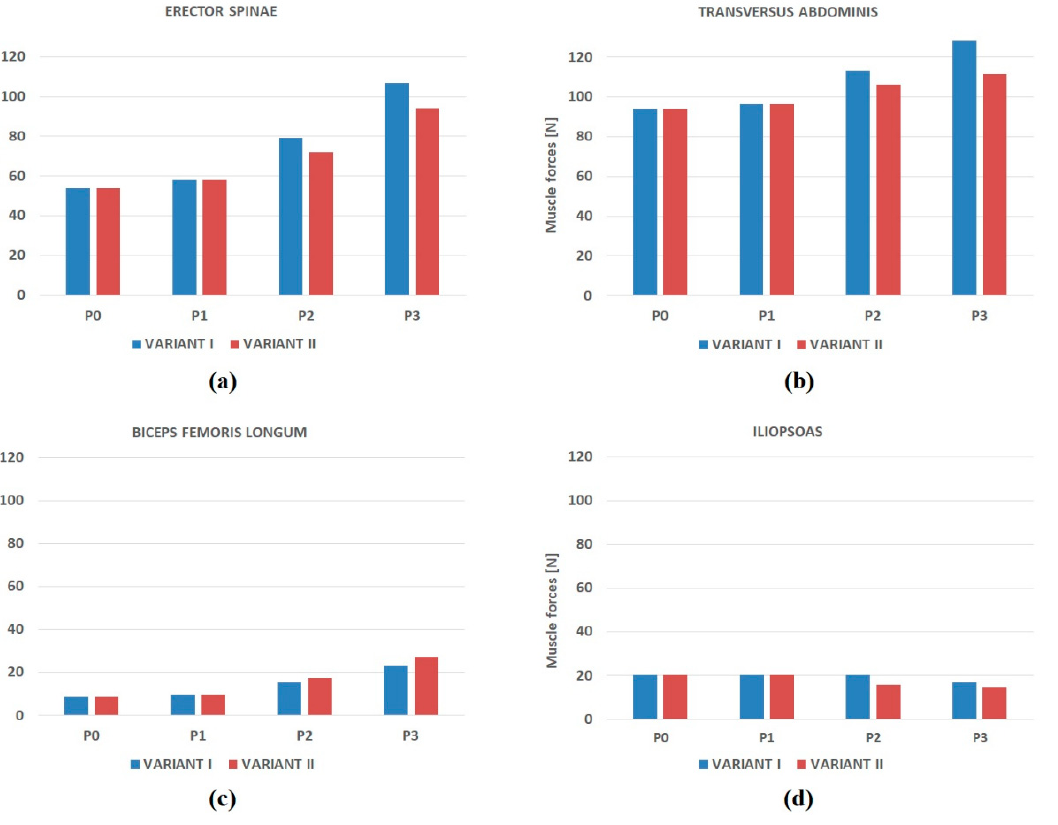
Figure 2. Muscle forces generated within the lumbopelvic complex. ( a ) Erector spinae, ( b ) transversus abdominis, ( c ) biceps femoris longum, ( d ) iliopsoas.